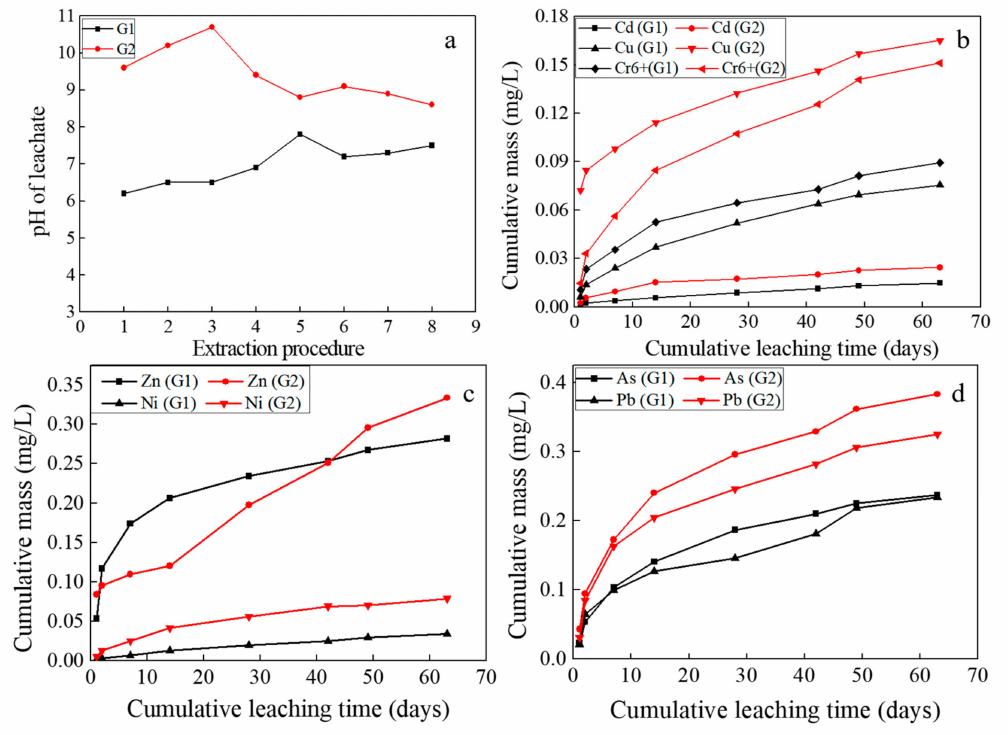
Figure 9. Evolution of pH and HMs from the monolithic asphalt mixture and that with asphalt stripped o ff (G1 and G2). ( a ) The pH value of the leachate, ( b ) The cumulative mass of Cd, Cu and Cr 6 + in the both samples, ( c ) The cumulative mass of Zn and Ni in the both samples, ( d ) The cumulative mass of As and Pb in the both